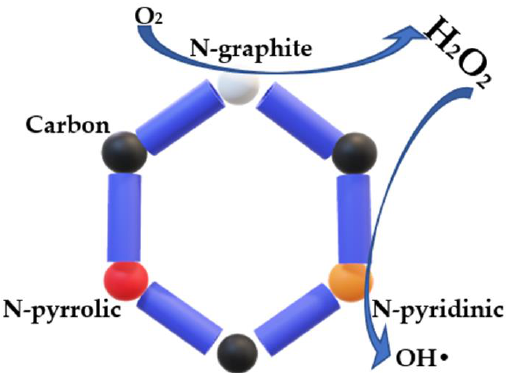
Figure 10. Schematic illustration of the effect of N-contained surface groups in the generation and activation of H 2 O 2 . Adapted from activation of H 2 O 2 . Adapted from [256].